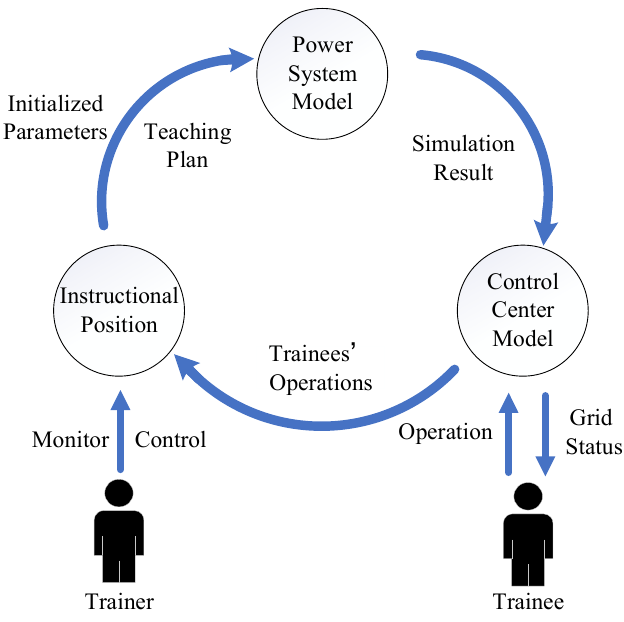
Figure 2. Data flow of a DTS.